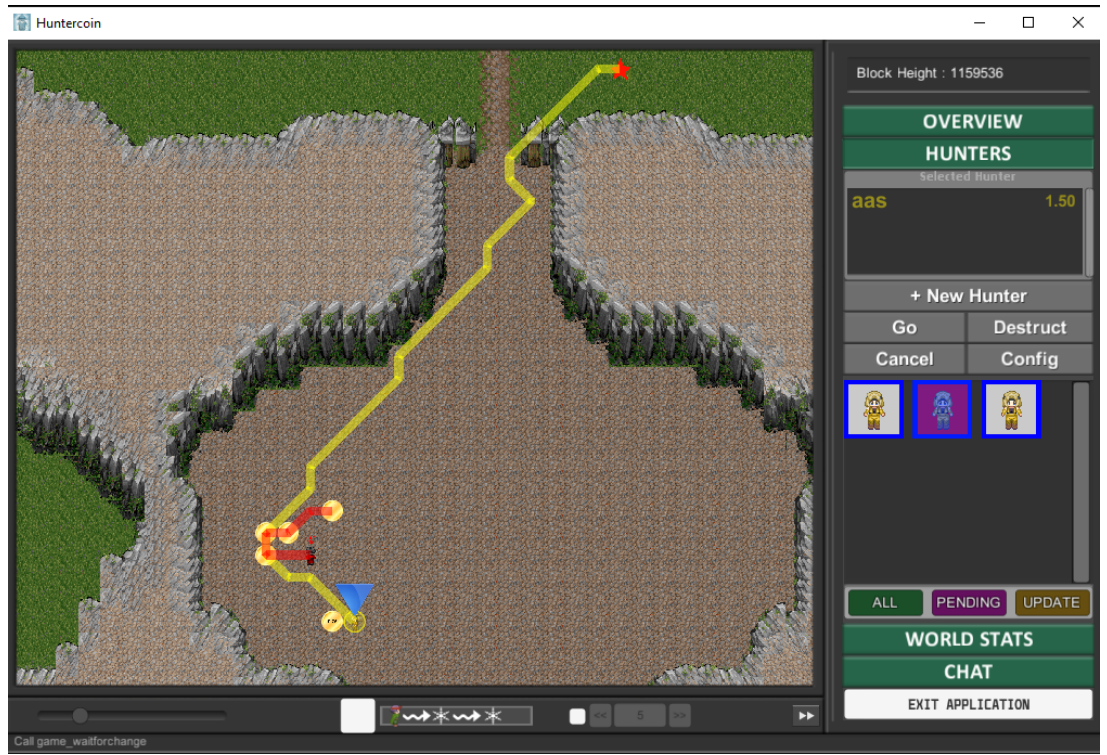
Fig. 1. Screenshot of the Unity client for Huntercoin, showing hunters collecting coins in the game world. Contributed by Andrew